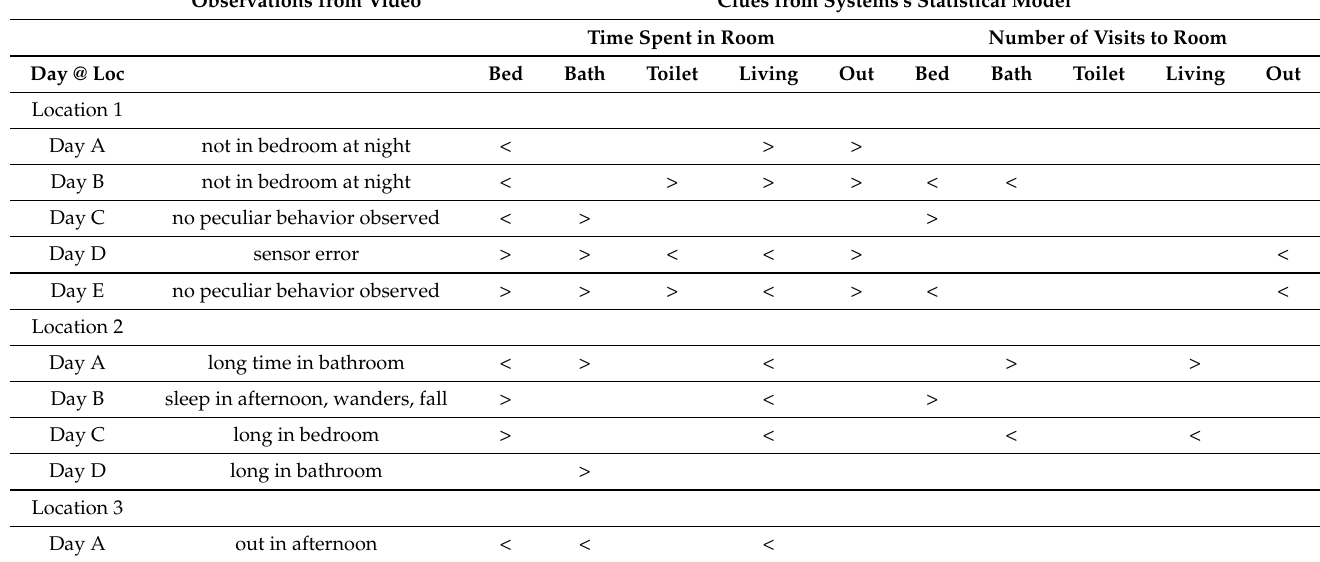
Table 5. This table compares the system’s clues about possible reasons for a deviating day to observations derived from watching the video. For each location, ‘>’ means more than expected, ‘<’ means less than expected, and an empty field indicates no deviation. Observations from Video Clues from Systems’s Statistical Model Time Spent in Room Number of Visits to